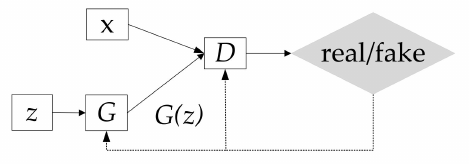
Figure 1. The structure of DCGAN.